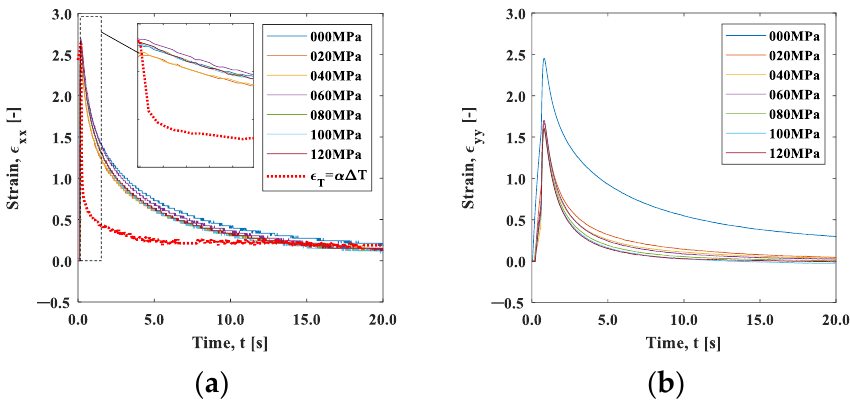
Figure 10. Strain – time curve measured by a strain gauge: ( a ) x-direction; and ( b ) y-direction. We now discuss the observed strain relaxation behavior. It is well known that viscoelastic materials exhibit exponential strain relaxation due to their viscosity. Although the origin of viscosity in this experiment is unclear, the strain relaxations shown in Figure 10 indicate exponential-like decay. Figure 11a,b are natural logarithm plots of the strain change during the cooling after the maximum temperature in Figure 10. It can be seen that the slope is not completely linear, indicating that the exponential-like decay cannot be represented by a single decay constant. However, a close look at the initial part of the graph indicates that the trend between t = 0 s and t = 0.4 s is approximately linear, as the inserts in these figures exhibit.